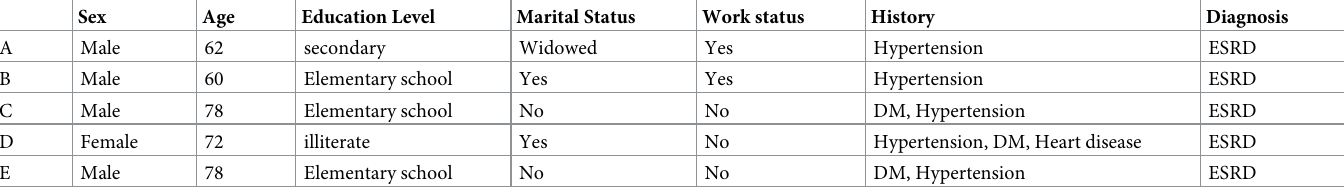
Table 1. Characteristics of the study participants (N = 5).